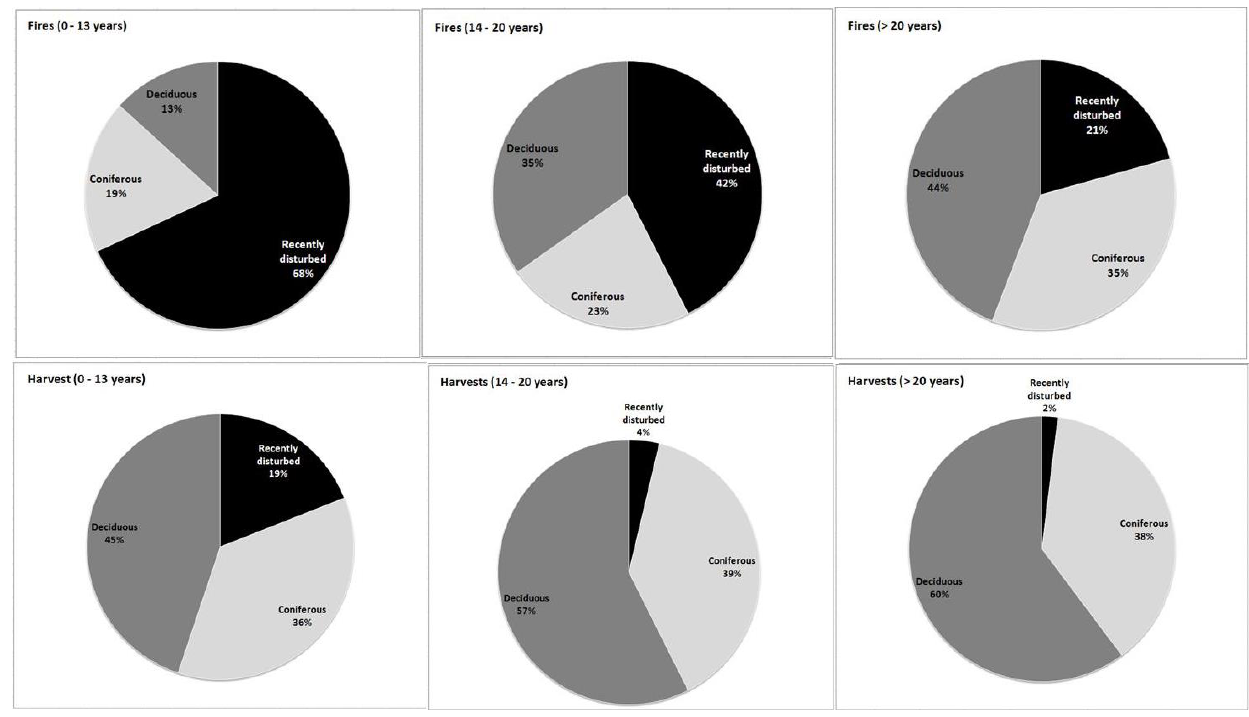
Figure 5. Comparison of cover composition between fire events and harvested agglomerations in three TSD classes. Only fires that had burned at least 40% of mature forest cover prior to the disturbance have been